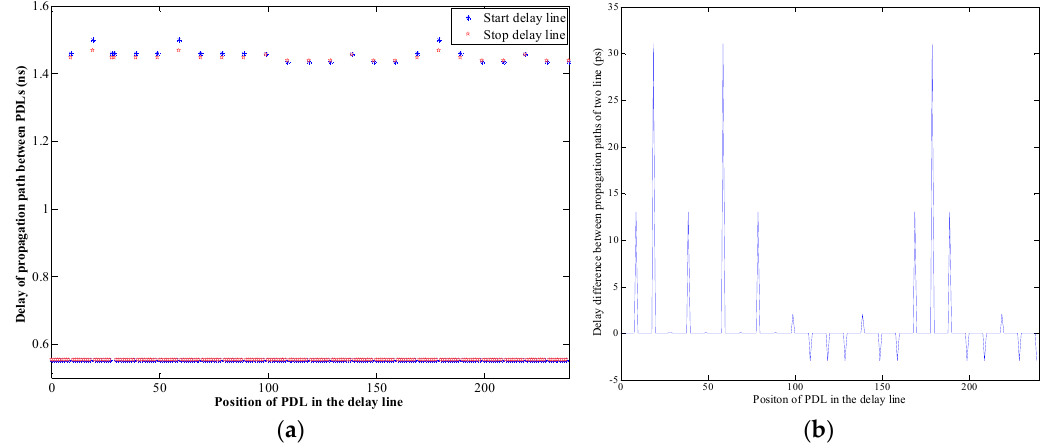
Figure 7. Delay characteristic of the propagation paths. ( a ) Delay of propagation paths of the two lines; ( b ) Delay difference between propagation paths of the two lines.